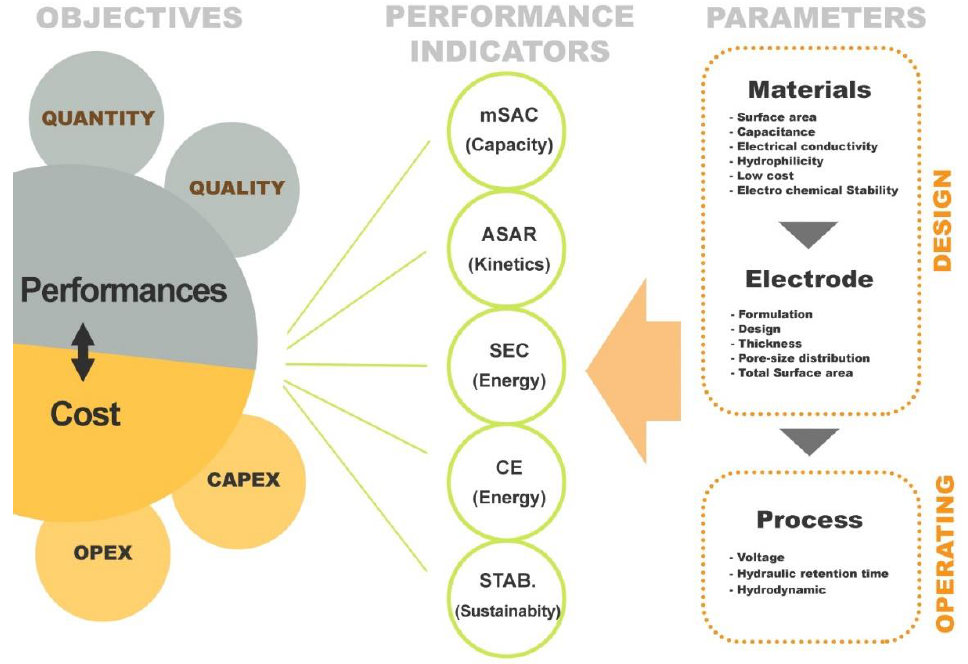
Figure 6. Schematic diagram of CDI performance indices.